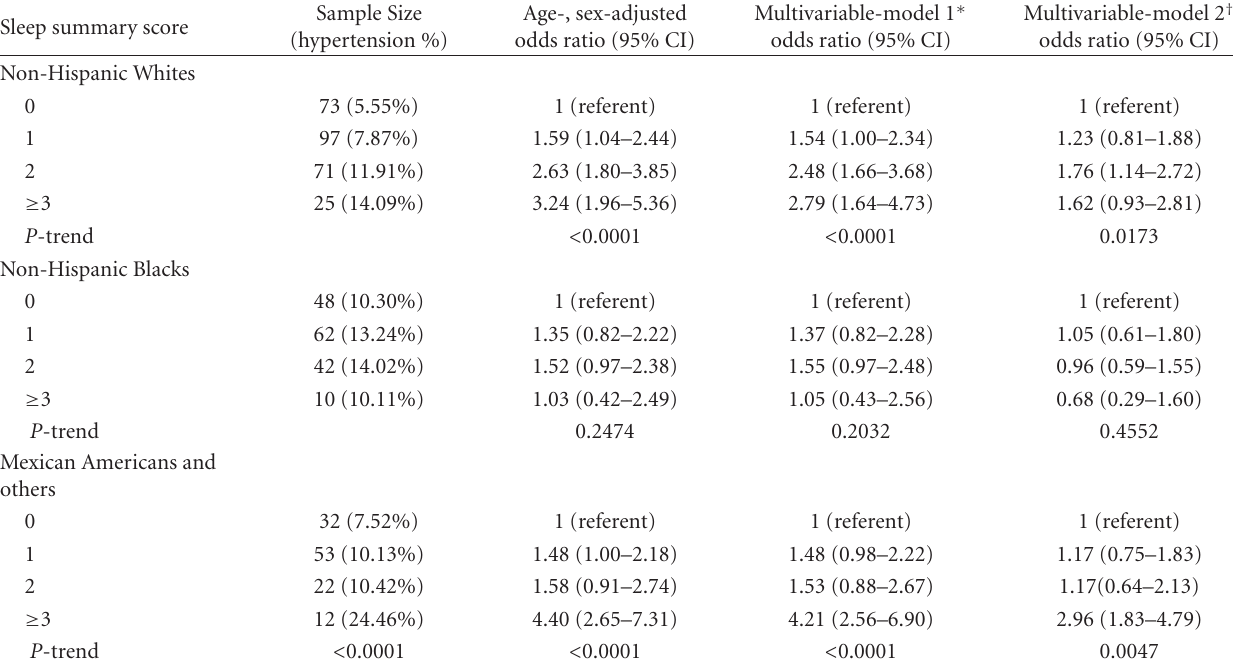
Table 4: Association between sleep variables and C-reactive protein levels > 1 mg/dL, by